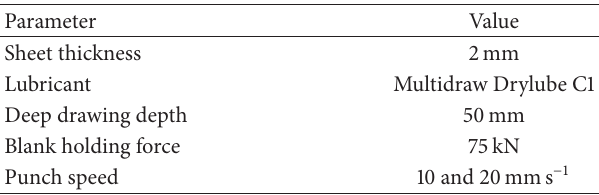
Table 2: Test parameters for smiley shape deep drawing. Parameter Value Sheet thickness 2 mm Lubricant Multidraw Drylube